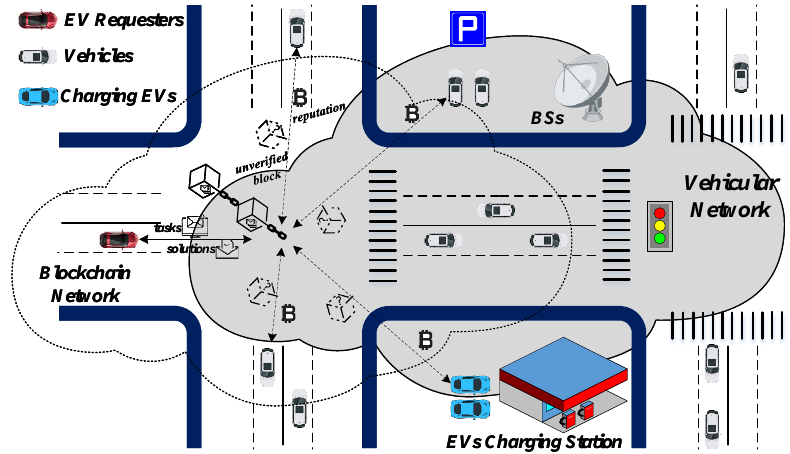
Figure 1. System model for performing spatial crowdsourcing tasks via blockchain-based interaction approach in vehicular